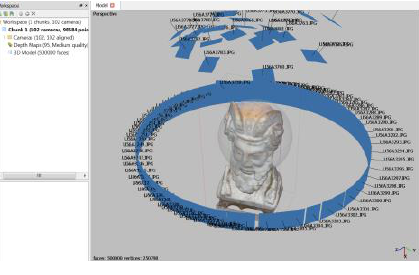
Figure 6. Agisoft PSPro-2 sets alignment